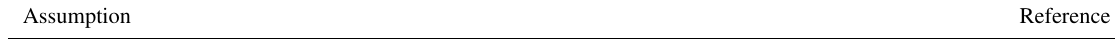
Table 1. Summary of assumptions underlying the RFI algorithm. Assumption